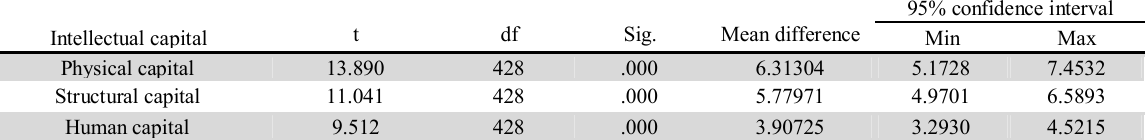
The summary of t-student on intellectual capital components